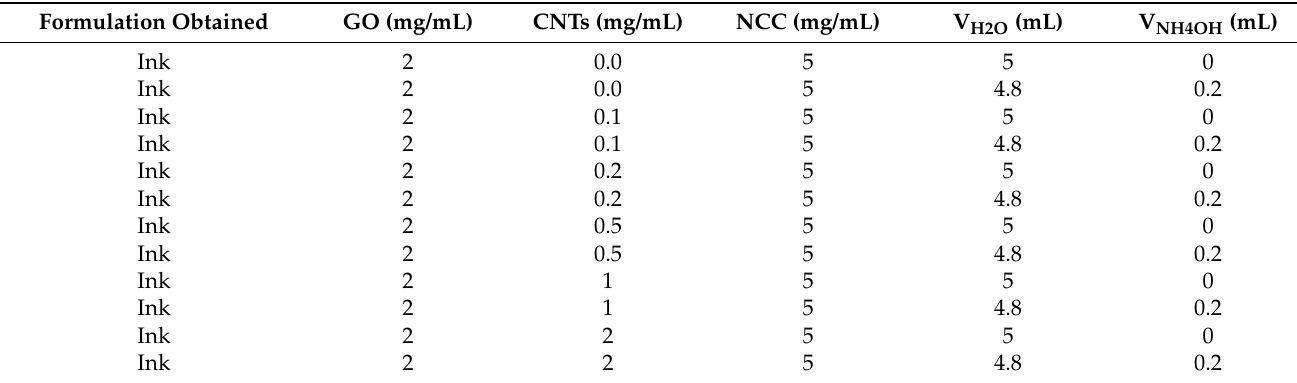
Table 1. The outcome of the hydrothermal treatment and composition of the GO/CNT/NCC (type II) ternary system in water at 180 ◦ C for 15 min.